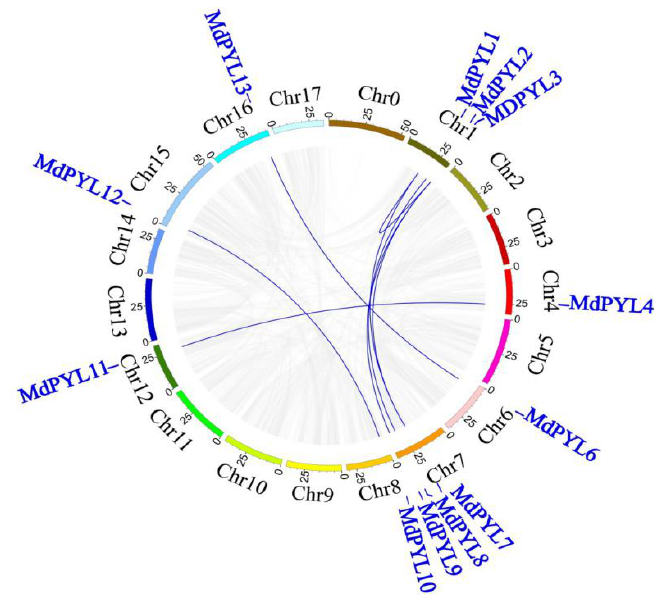
Figure 4. The synteny analysis of MdPYL s in the apple. Gray lines denote all synteny blocks in the apple genome, and the blue lines denote MdPYL duplicated gene pairs.